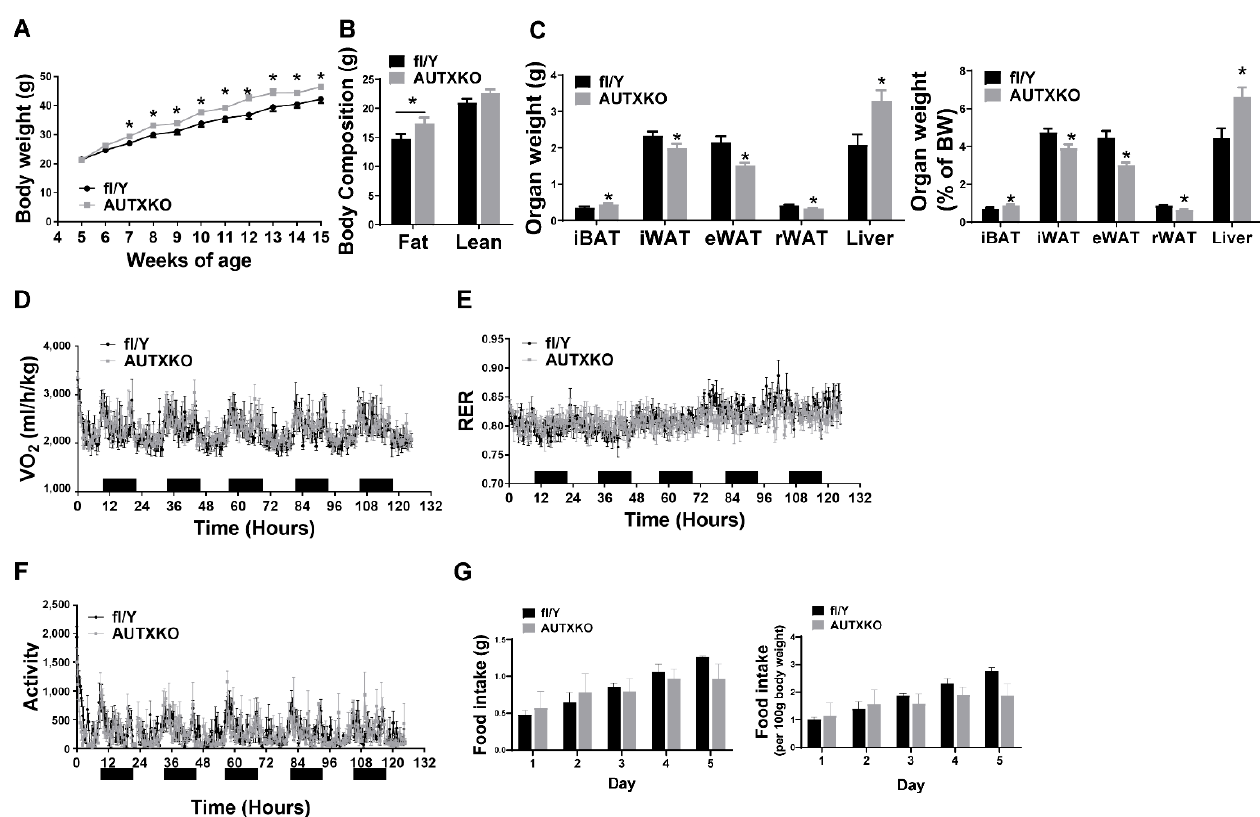
Figure 5. Utx deficiency in adipocytes reduces fat mass while increasing liver weight in mice fed a high-fat diet. Five-week-old male AUTXKO and fl/Y animals were challenged with an HFD. ( A – C ): ( A ) Body weight; ( B ) Fat and lean mass composition; ( C ) Organ weight ( left ) and organ weight normalized to body weight ( right ) of iBAT, iWAT, eWAT, rWAT and liver in male AUTXKO and fl/Y animals. ( D – G ): 13-week-old male AUTXKO and fl/Y mice fed HFD were put in TSE PhenoMaster metabolic cage system for metabolic characterization. ( D ) Oxygen consumption; ( E ) RER; ( F ) Locomotor activity; ( G ) Daily food consumption presented as food gram/mouse/day ( left ) and food gram/100 g body weight ( right ) in HFD-fed AUTXKO and fl/Y animals. All data are presented as mean ± S.E.M.; n = 4/group; * p < 0.05 vs. fl/Y